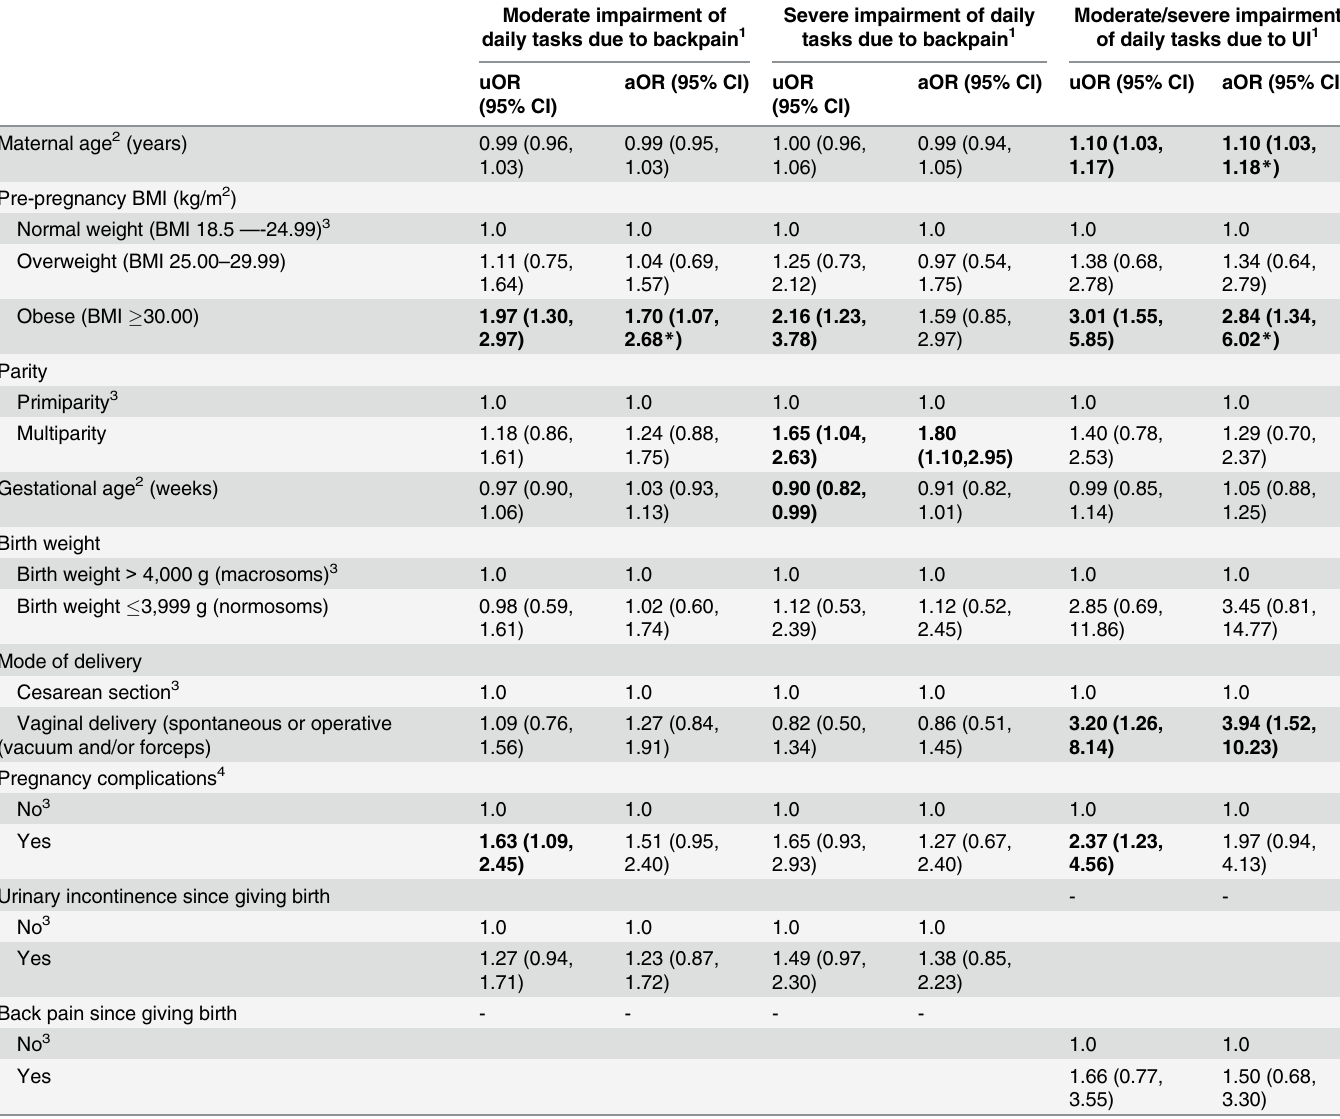
Table 3. Crude and adjusted odds ratios and 95% confidence intervals for factor related to severity of impairment on daily tasks due to back pain and urinary incontinence at 12 months postpartum.